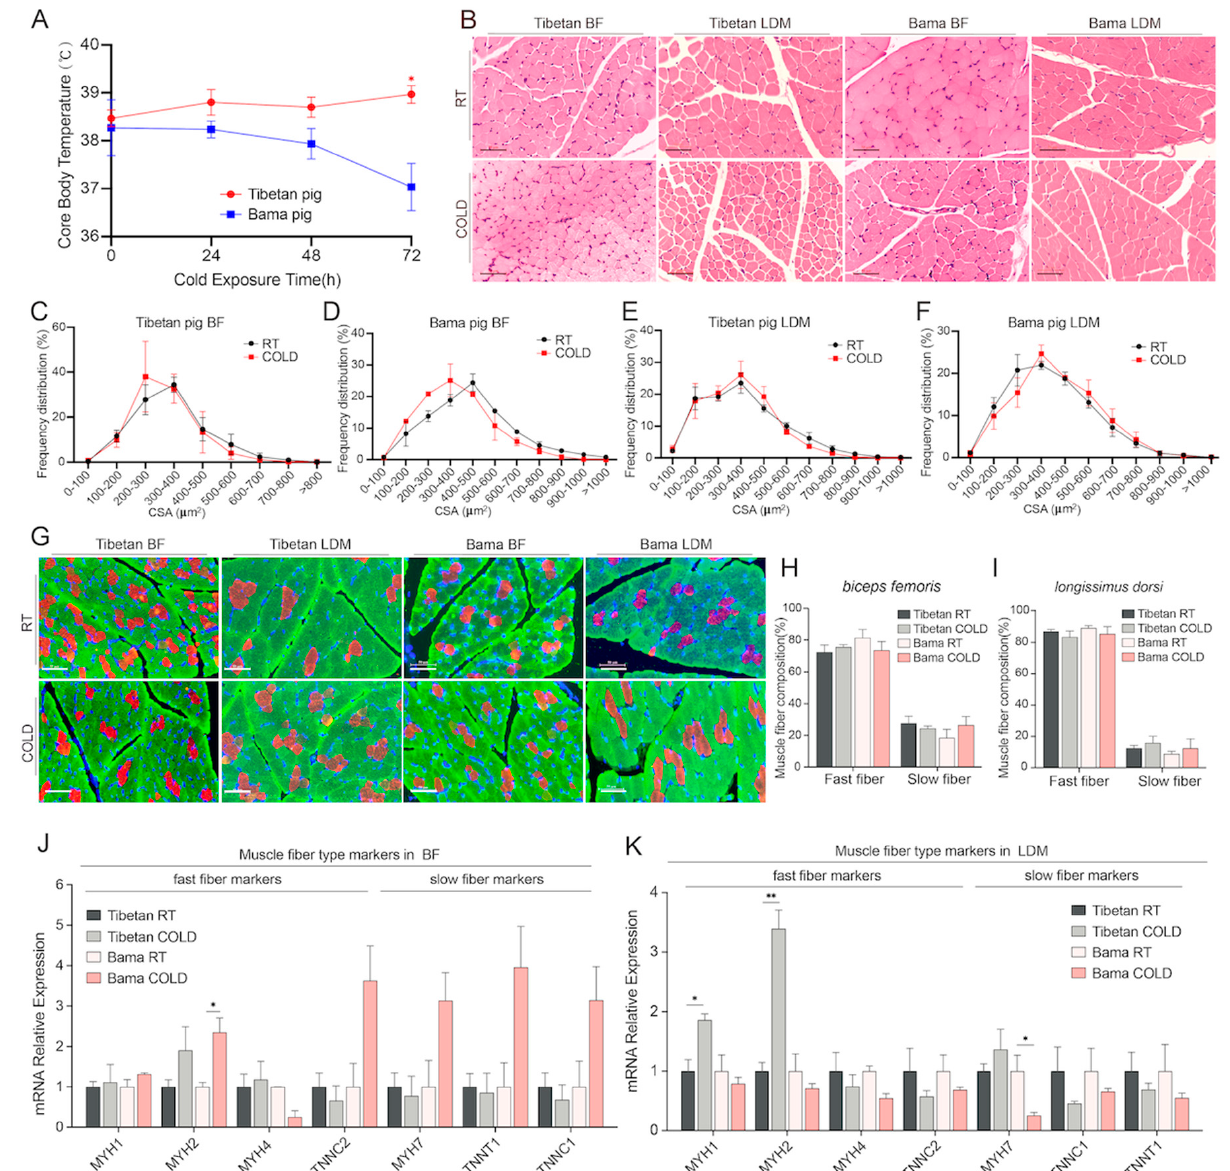
Figure 1. Effects of short-term cold exposure on the core body temperature, muscle fiber area distribution, and muscle fiber type composition in Tibetan pigs (TP) and Bama pigs (BP). ( A ) Core body temperature of TP and BP during short-term cold exposure. ( B – F ) H&E staining of tissue sections of the BF and LDM from TP and BP ( B ). Representative images are shown. Scale bar, 50 µ m. The myofiber cross-sectional area distribution in the biceps femoris (BF) and longissimus dorsi muscles (LDM) of TP and BP was measured by Image J (n = 3 muscle samples) ( C – F ). ( G – I ) Immunofluorescence analysis of fiber type composition in the BF and LDM of TP and BP ( G ). The different myosin heavy chain isoforms are indicated by green (fast fibers) and red (slow fibers) fluorescence. Representative micrographs and the corresponding quantitative results ( H , I ) are shown (n = 3). Scale bar, 50 µ m. ( J , K ) mRNA expression levels of fast and slow myofiber markers in the BF and LDM of TP and BP (n = 3). The results are presented as the mean ± standard error mean (SEM). * p < 0.05; ** p <